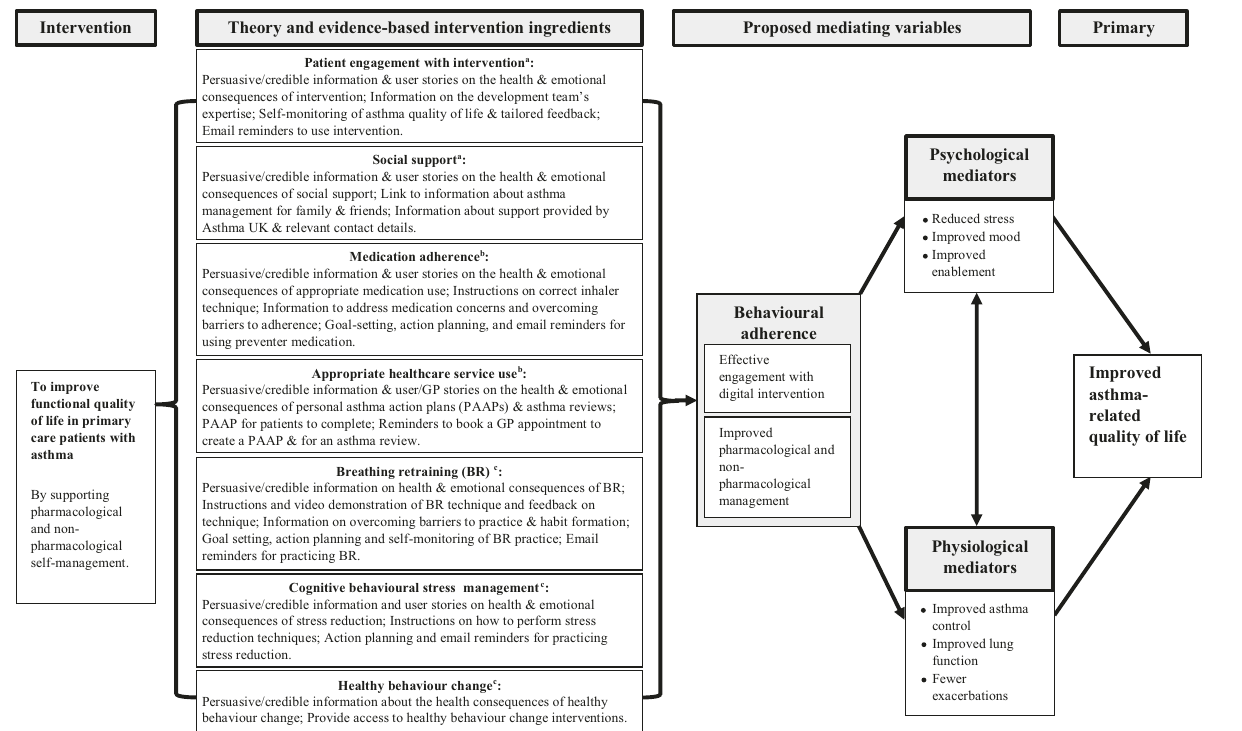
Fig. 5 Logic Model of My Breathing Matters intervention. a Uptake and engagement facilitation; b Pharmacological support; c Non- pharmacological